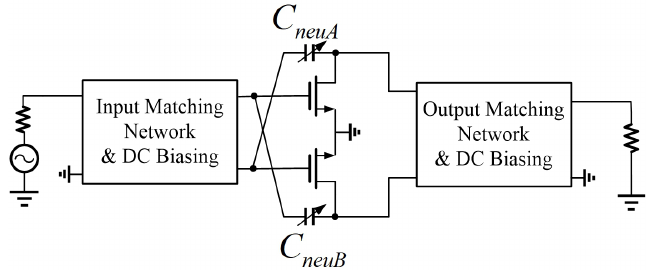
Figure 2. Schematic for neutralization capacitor